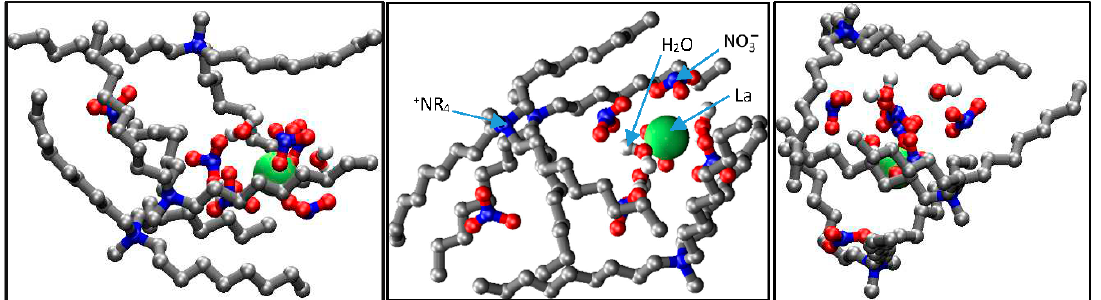
Figure 8. Three ‘snapshot’ images taken at 225 ps apart (( left ) to ( right )) from the classical MD simulations showing aggregation of water, nitrate, and ammonium cations around an La center within a 60 Å 3 box of toluene. For clarity, the toluene box is omitted, and H atoms are colored white, oxygen atoms red, nitrogen atoms blue, carbon atoms grey, and the La atom green.